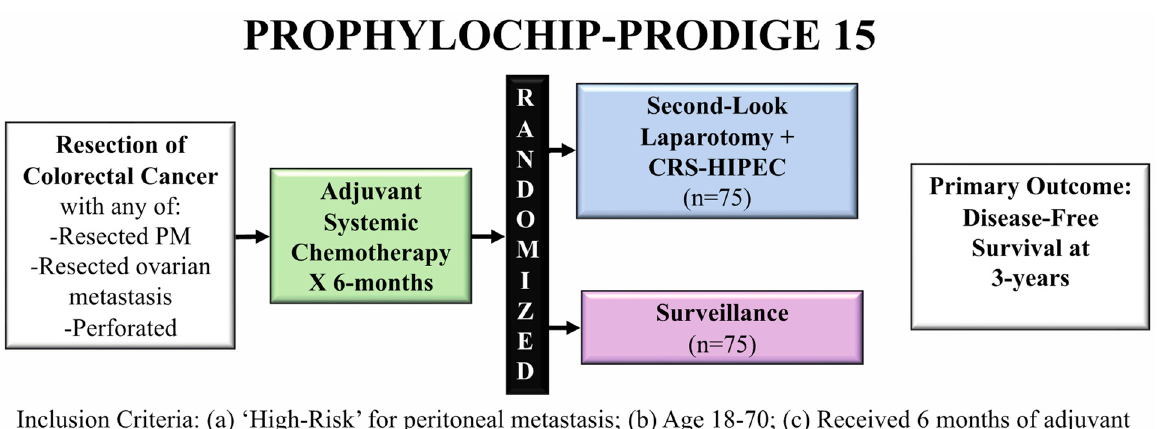
Figure 4. PROPHYLOCHIP-PRODIGE 15 trial schema comparing second-look laparotomy with CRS-HIPEC to surveillance in high-risk patients for peritoneal